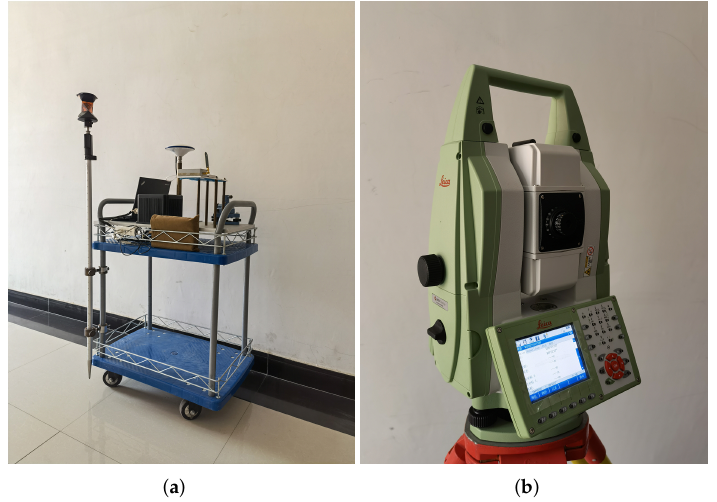
Figure 3. Experimental car and automatic tracking total station. ( a ) Experimental car. ( b ) Leica TS50 automatic tracking total